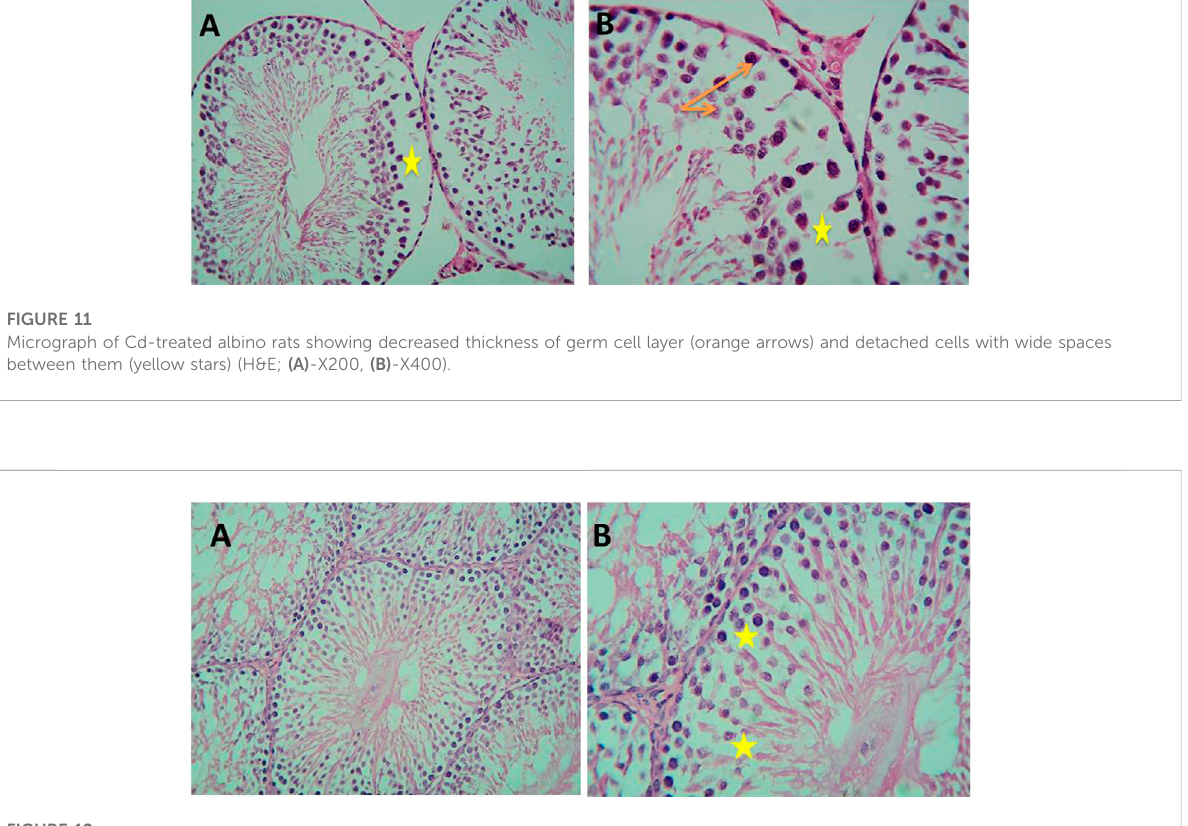
vesicles (Figure 6A). Leydig cells (asterisk) showed blunting of surface villi, blurring of cell borders, yet preserved lipid droplets (arrows) in their cytoplasm (Figure 6B).